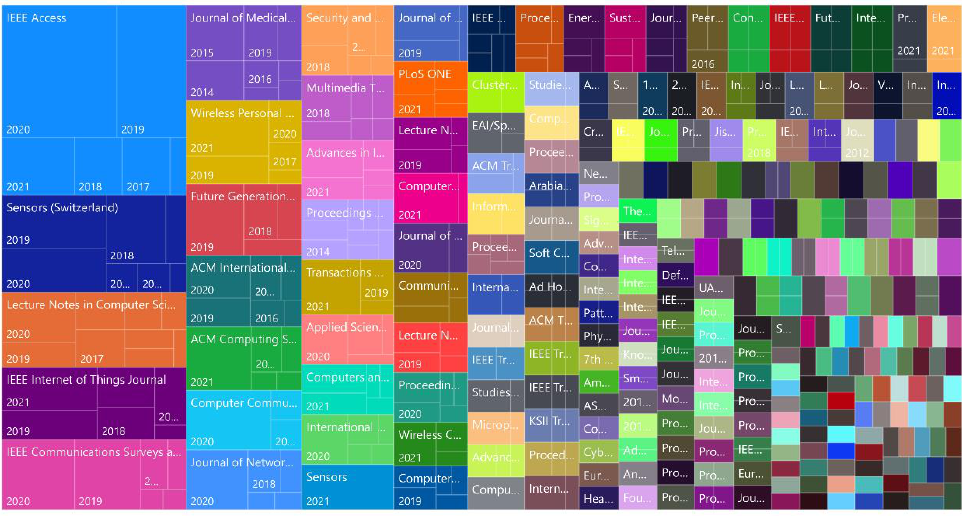
Figure 4. Physical layer attack search from Scopus categorized by research field.